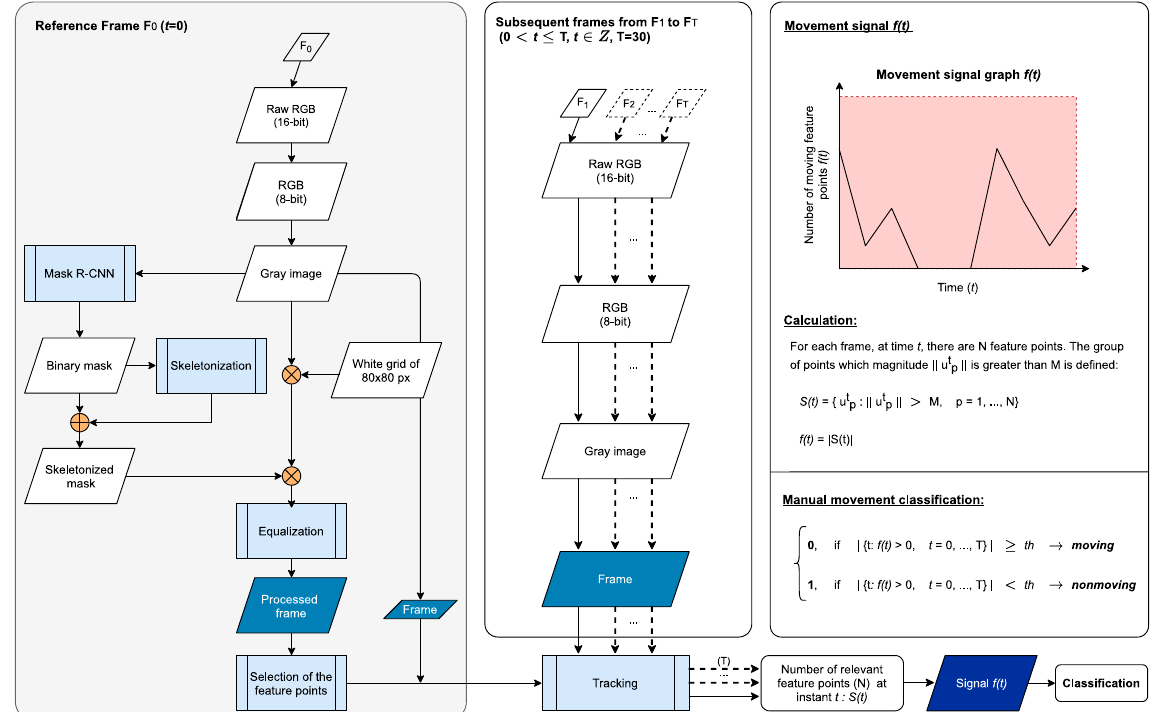
Figure 1. Flowchart of the algorithm steps for the human movement detection in RGB data.